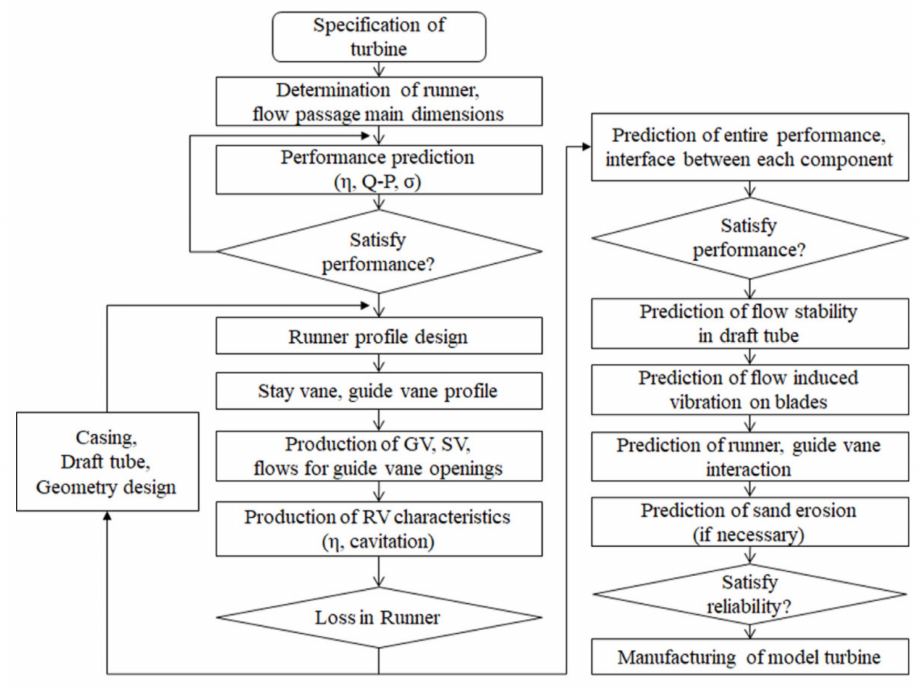
Figure 3. Block diagram of the design process for the hydraulic turbine.